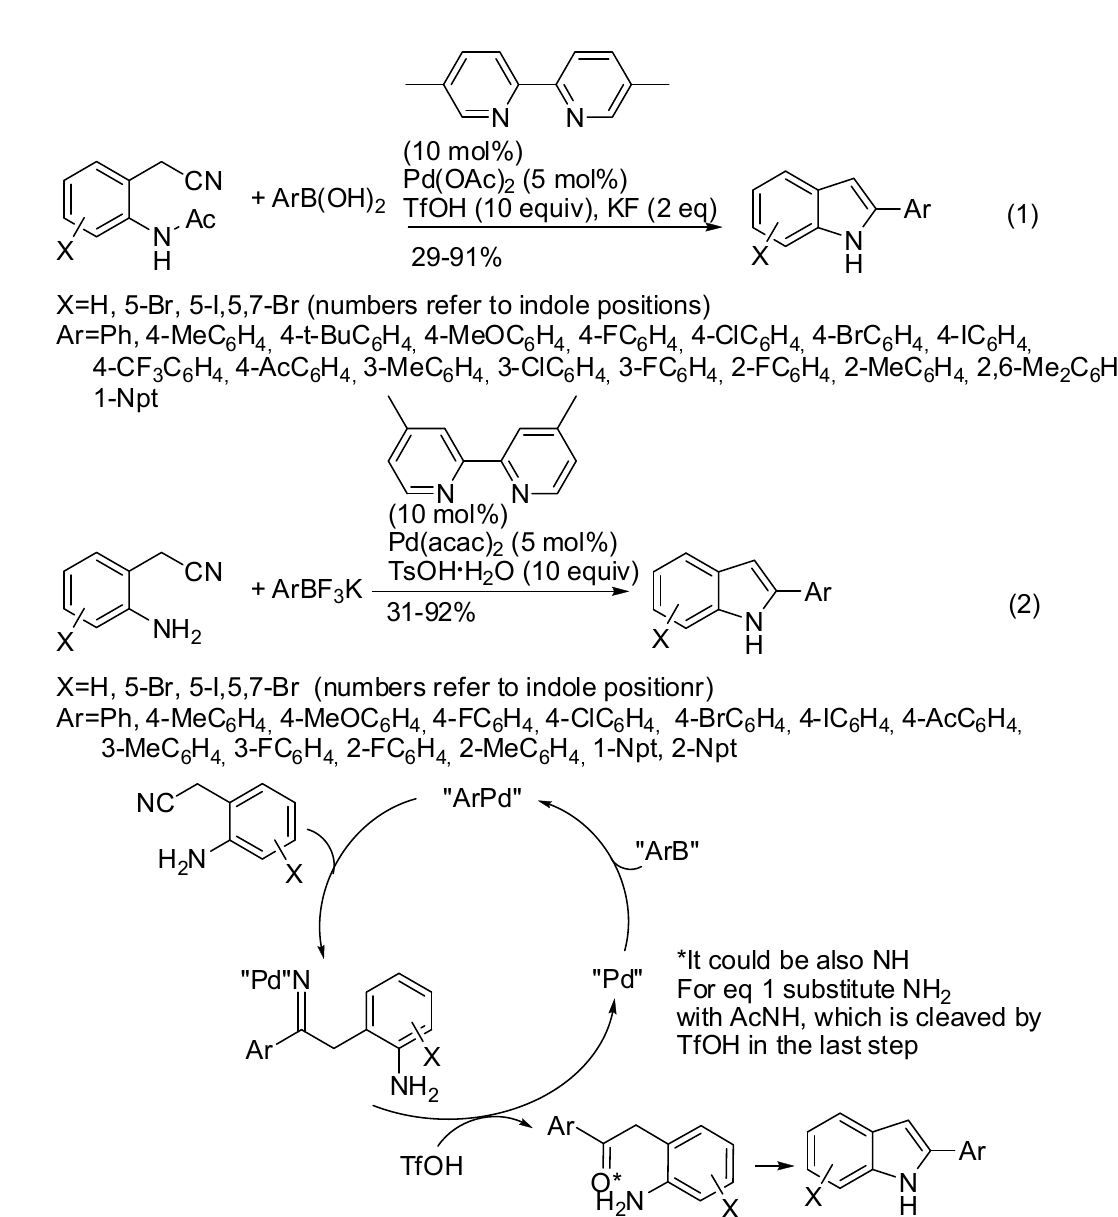
X = 3-Cl, 4-Me, 4-F, 4-CF 3 , 4-Cl, 5-Cl, 5-MeO